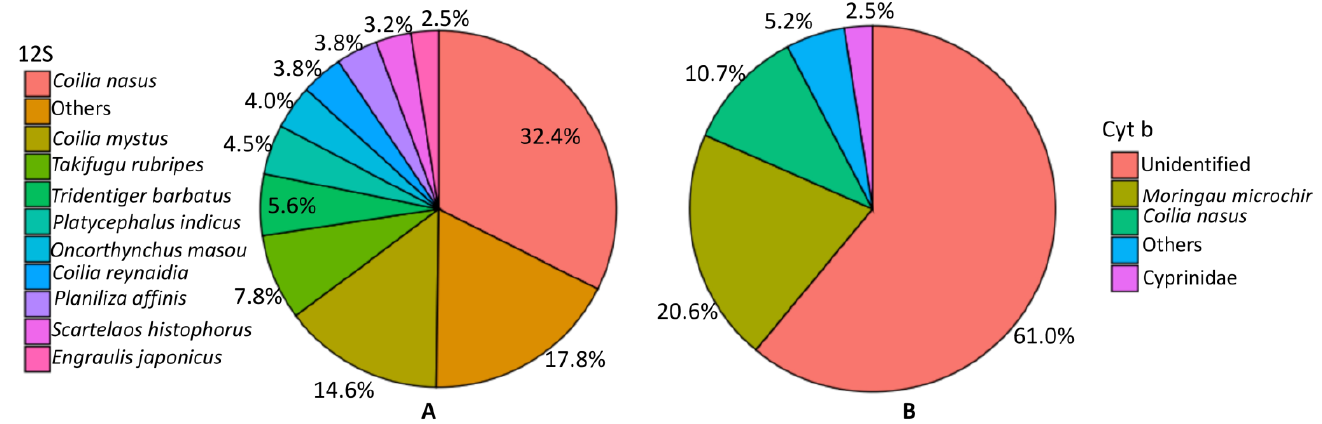
Figure 4. The species percentage composition of fish eggs and larvae in Oujiang River Estuary identified by molecular analysis: ( A ) 12S DNA metabarcoding, ( B ) Cyt b DNA metabarcoding.